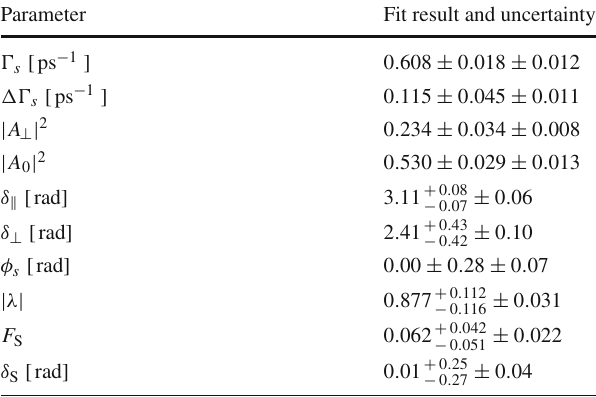
Table 3 Results of the maximum-likelihood fit, described in Sect. 6, to the B 0 s → J /ψ( e + e − ) φ decays including all acceptance and resolution effects. The first uncertainty is statistical and the second is systematic Parameter Fit result and